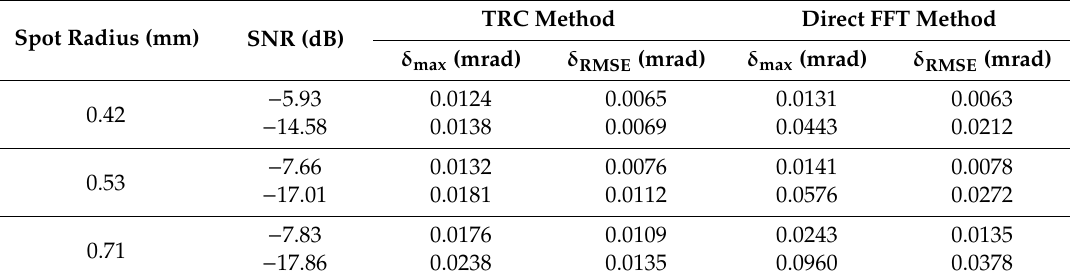
Table 1. The errors in di ff erent spot radius and SNR